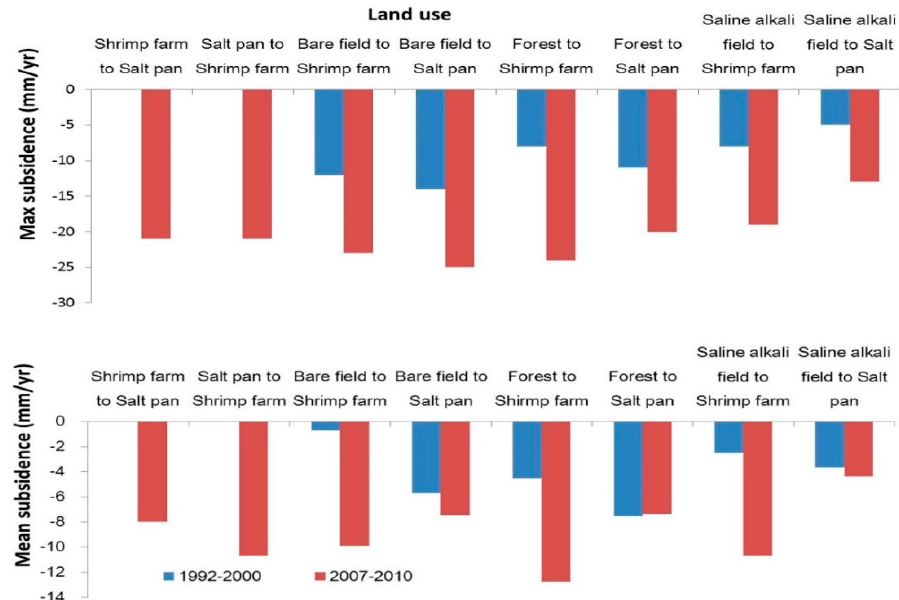
Figure 7. Statistics of the subsidence for changed land-use types in P1 (1992-2000) and P2